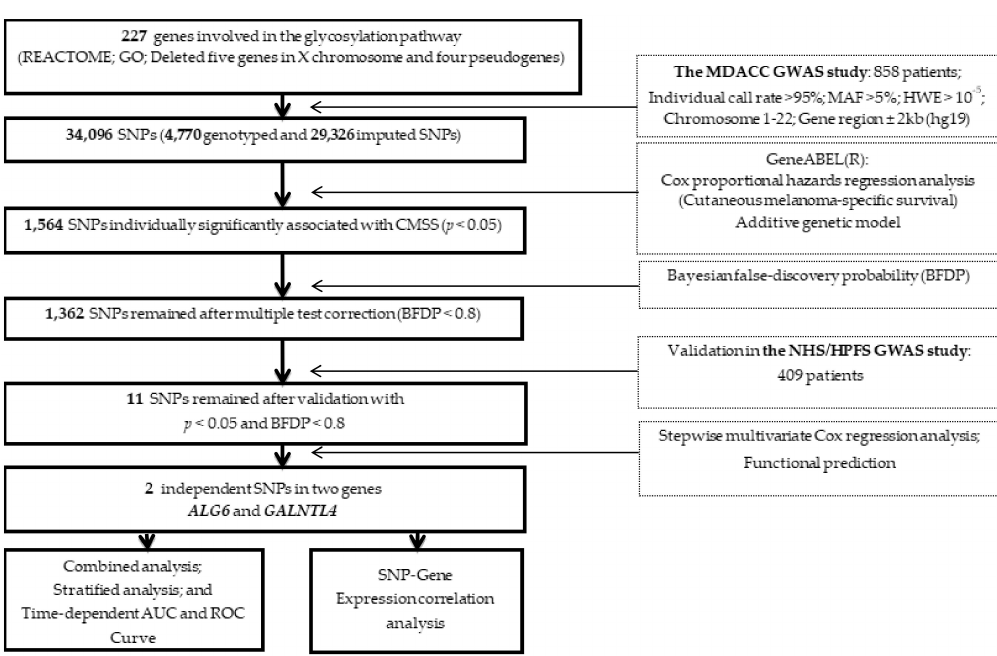
Figure 1. A flow chart of the study design for the selected Single-nucleotide polymorphisms (SNPs) in the glycosylation pathway-related